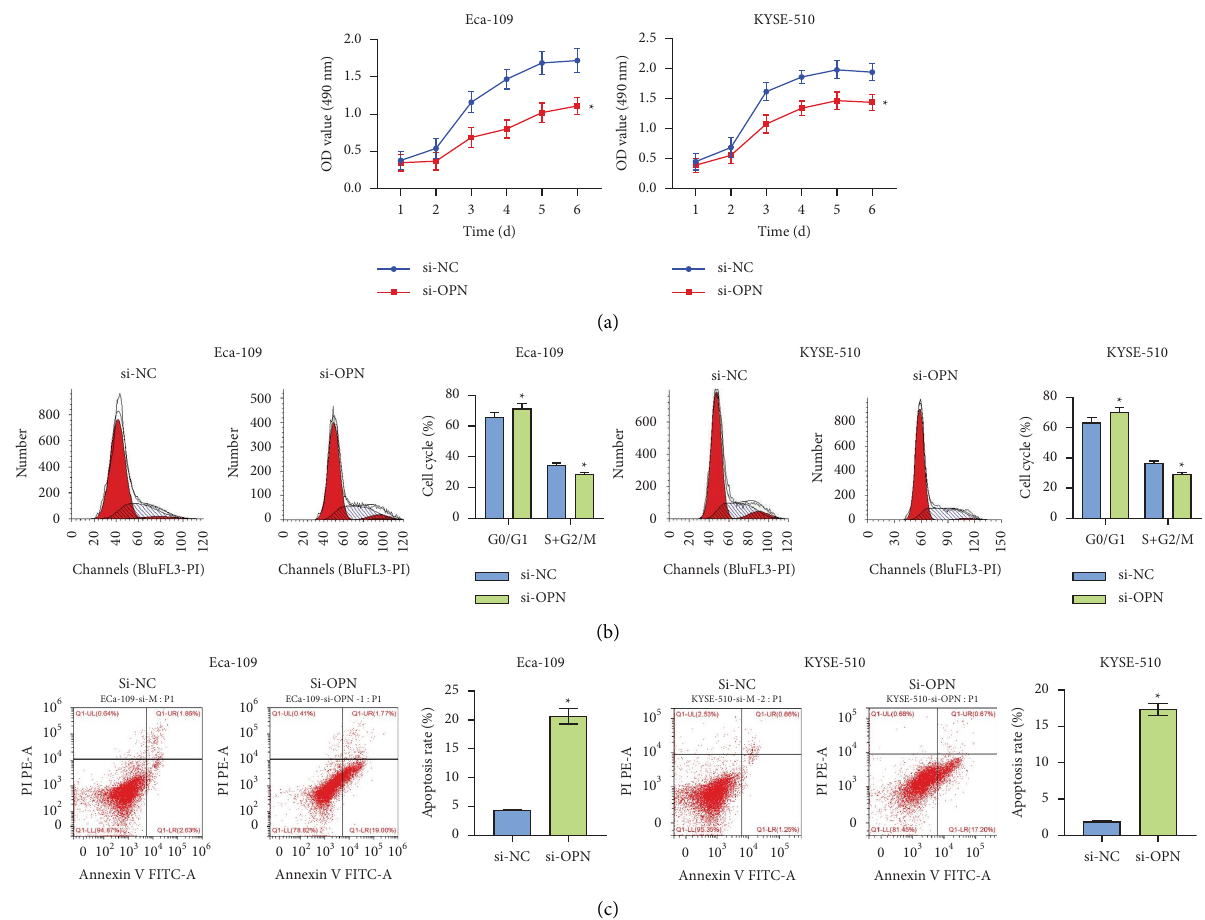
Figure 3: OPN knockdown could inhibit esophageal squamous carcinoma cell proliferation. (a) Te proliferation ability of Eca-109 and KYSE-510 cells. (b) Cell cycle distribution of Eca-109 and KYSE-510 cells. (c) Cell apoptosis distribution of Eca-109 and KYSE-510 cells. ∗ P < 0 . 05 compared with si-NC.